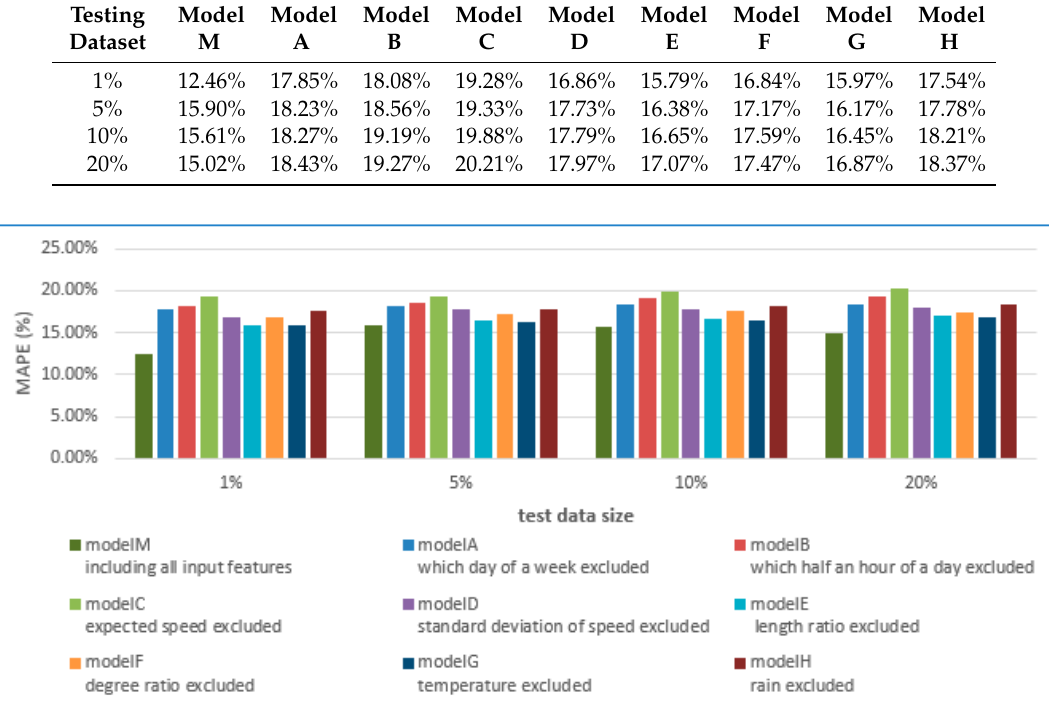
Figure 11. Influence of different input factors on ANN model.